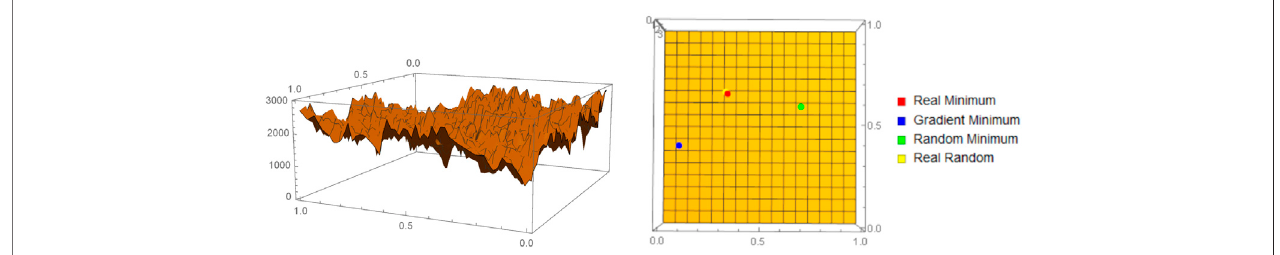
FIGURE 1 | On the left we have a visualization of the algorithmic cost function, as approximated by coarse BDM, corresponding to a simple bilinear regression problem. From the plot we can see the complex nature of the optimization problem. On the right we have con fi rmation of these intuitions in the fact that the best performing optimization algorithm is a random pooling of 5,000